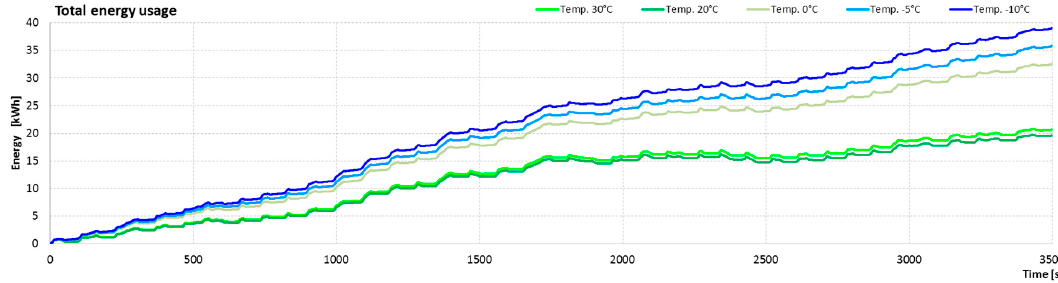
Figure 27. Simulation results of energy consumption by an electric bus for the Gdynia-Flat route during changes in ambient temperature.